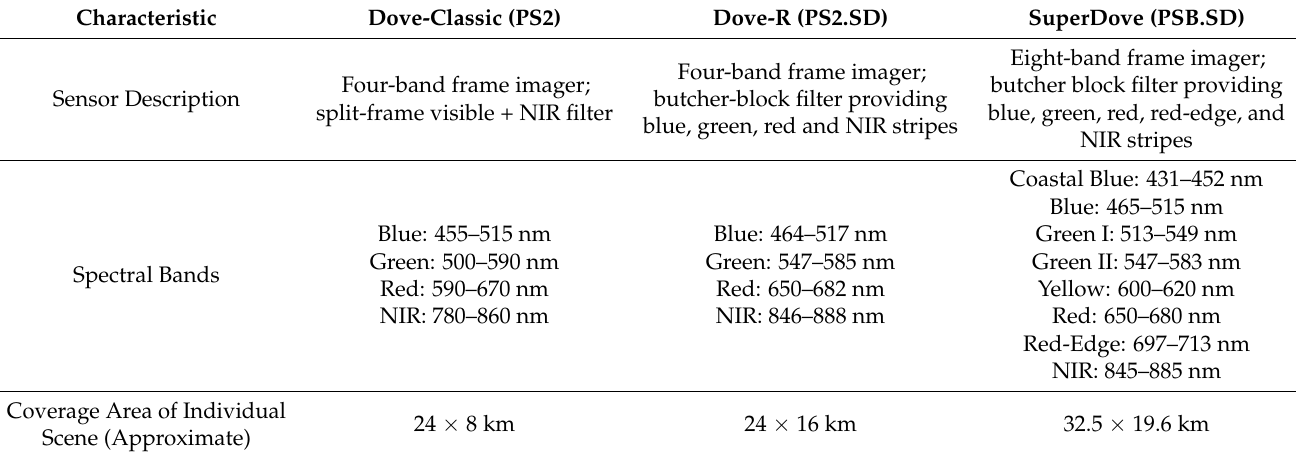
Table 1. Summary of the differences between the three most recent generations of PlanetScope, adapted from Planet’s Imagery Product Specification document [15]. All sensors collect data at 12-bit radiometric resolution with an approximate ground sampling distance of 3.7 m. The reported revisit time is daily at